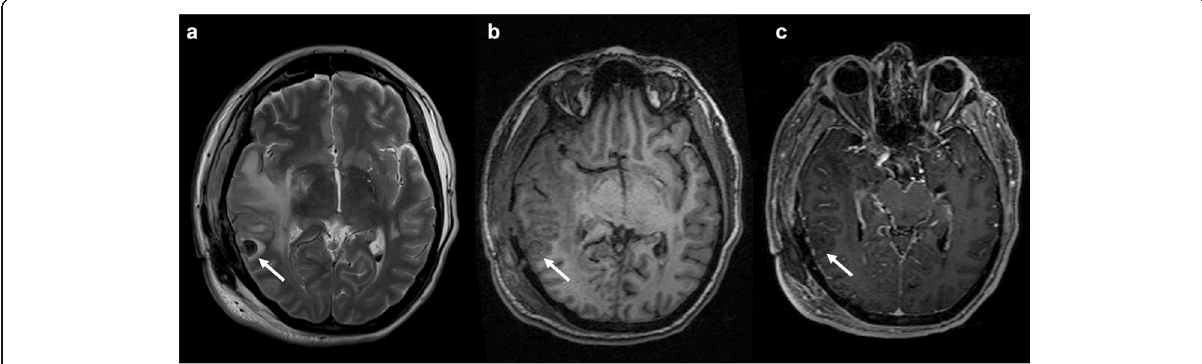
Fig. 2 Surgical sponge. Axial T2-weighted ( a ), unenhanced ( b ), and post-contrast ( c ) axial T1-weighted images showing an ovoidal mass (arrow) in the right superior temporal gyrus with low signal on both sequences without